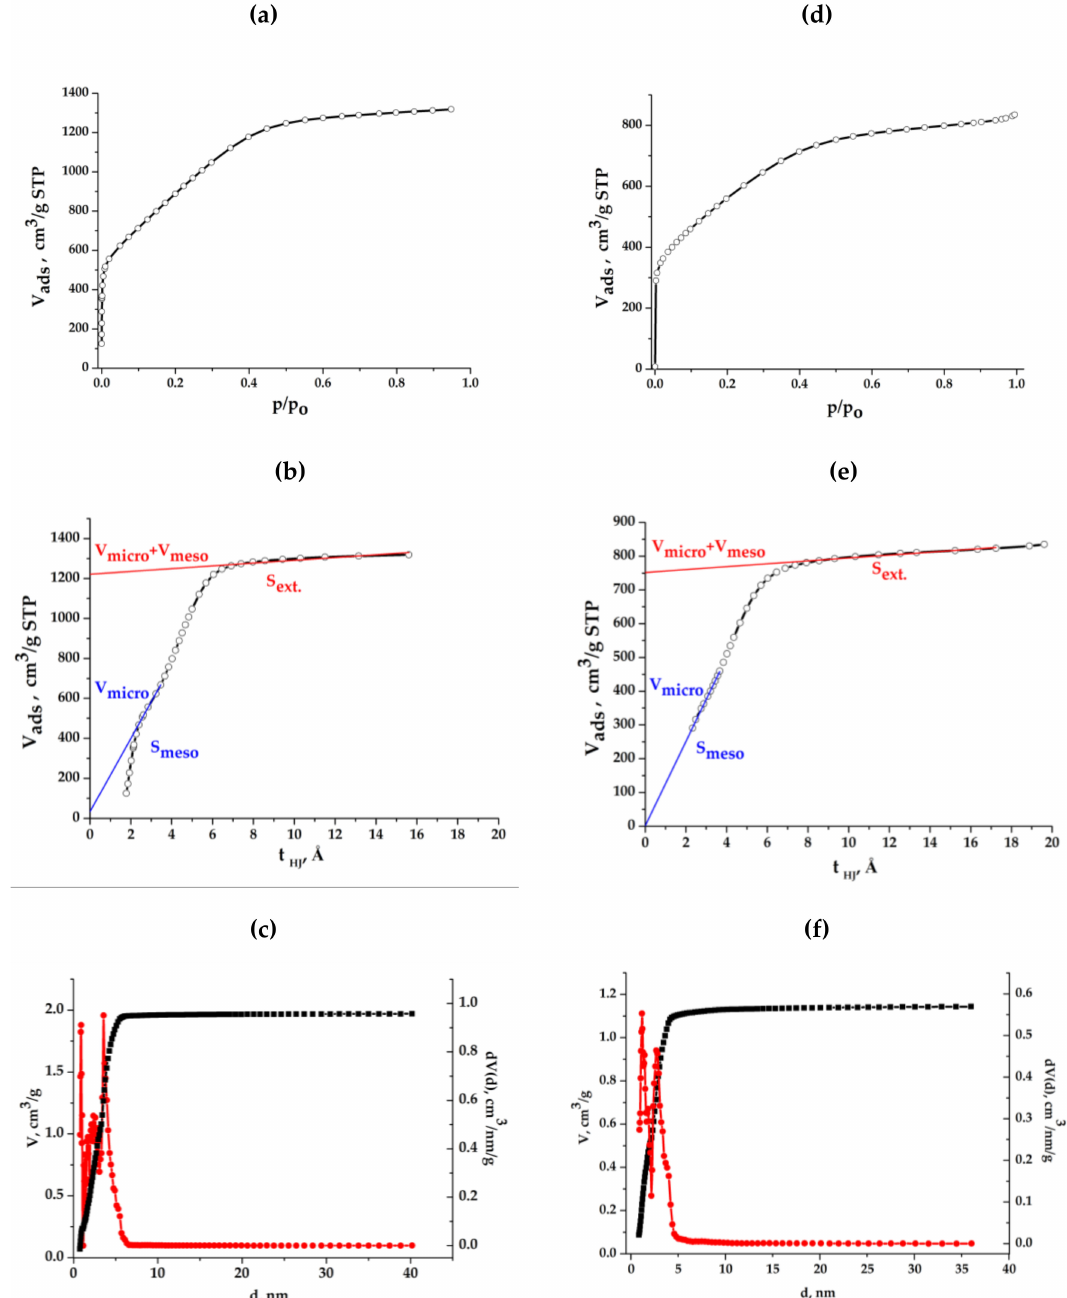
Figure 15. Nitrogen sorption isotherms, t-plot method, pore volume and size distribution (non-local density functional theory (NLDFT) model) for Graphene-Containing Mesoporous Carbon (GMC): activated carbon ( a – c ) and the electrode obtained from GMC ( d – f